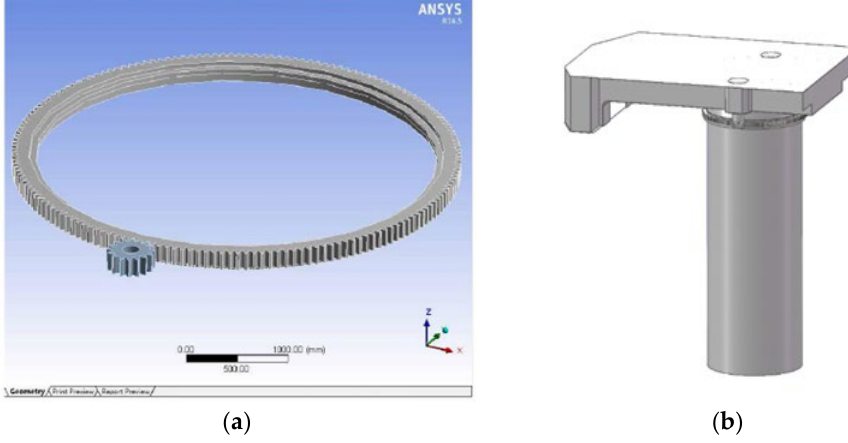
Figure 3. ( a ) Pinion and large gear ring meshing model; ( b ) assembly body model.